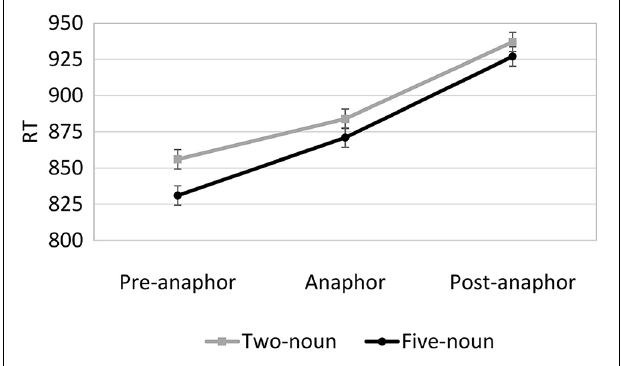
FIGURE 3 | Experiment 2A mean anaphor sentence reading times per region (error bars indicate SE of the